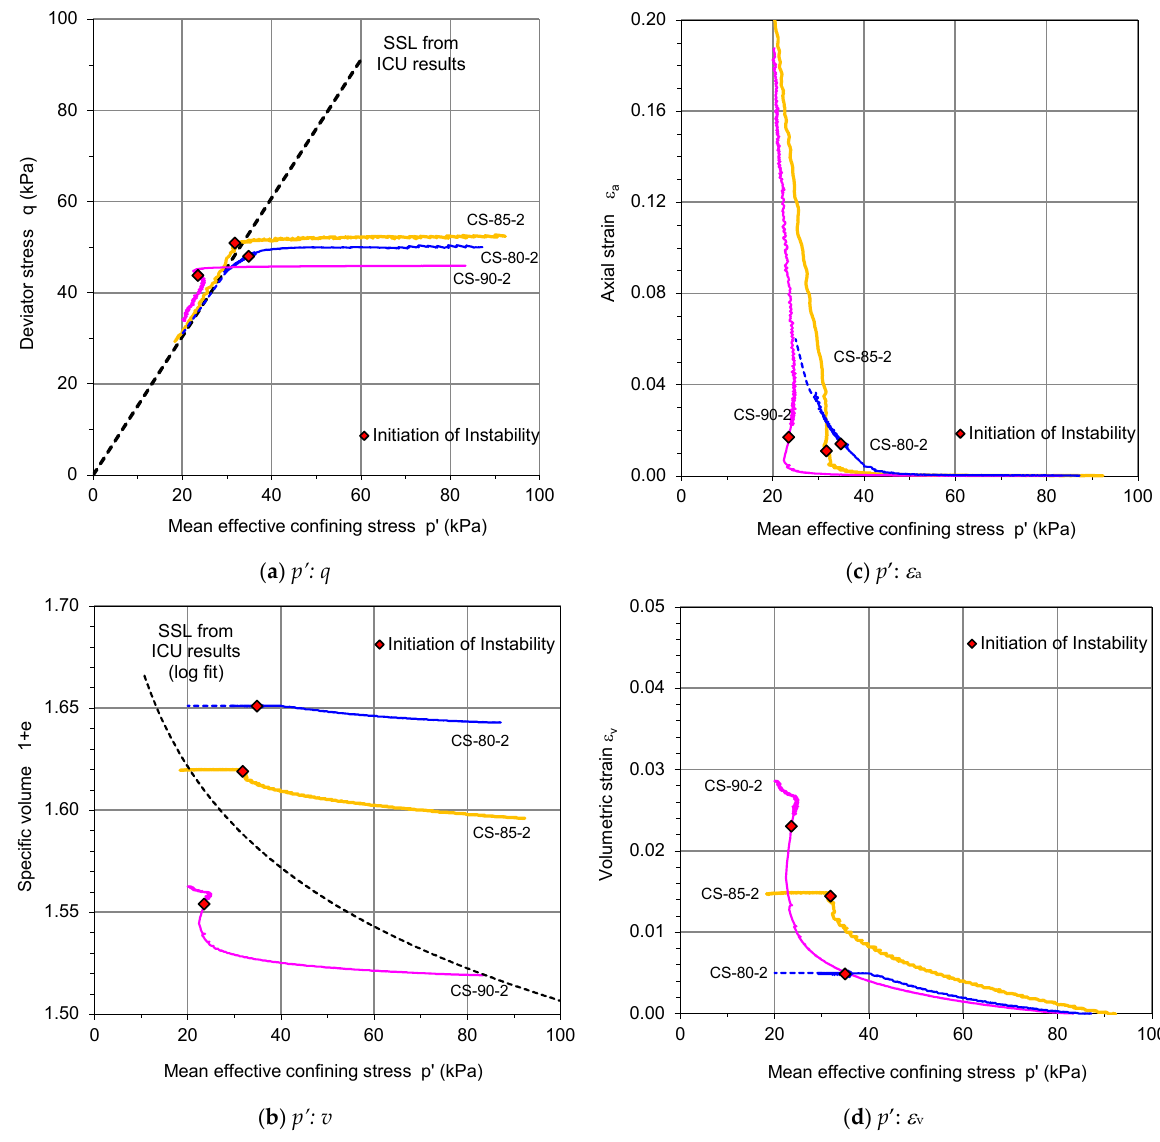
Figure 10. Typical results of the CS tests on the residual soil ( a ) p’ : q , ( b ) p’ : v, ( c ) p’ : a , and ( d ) p’ : v .